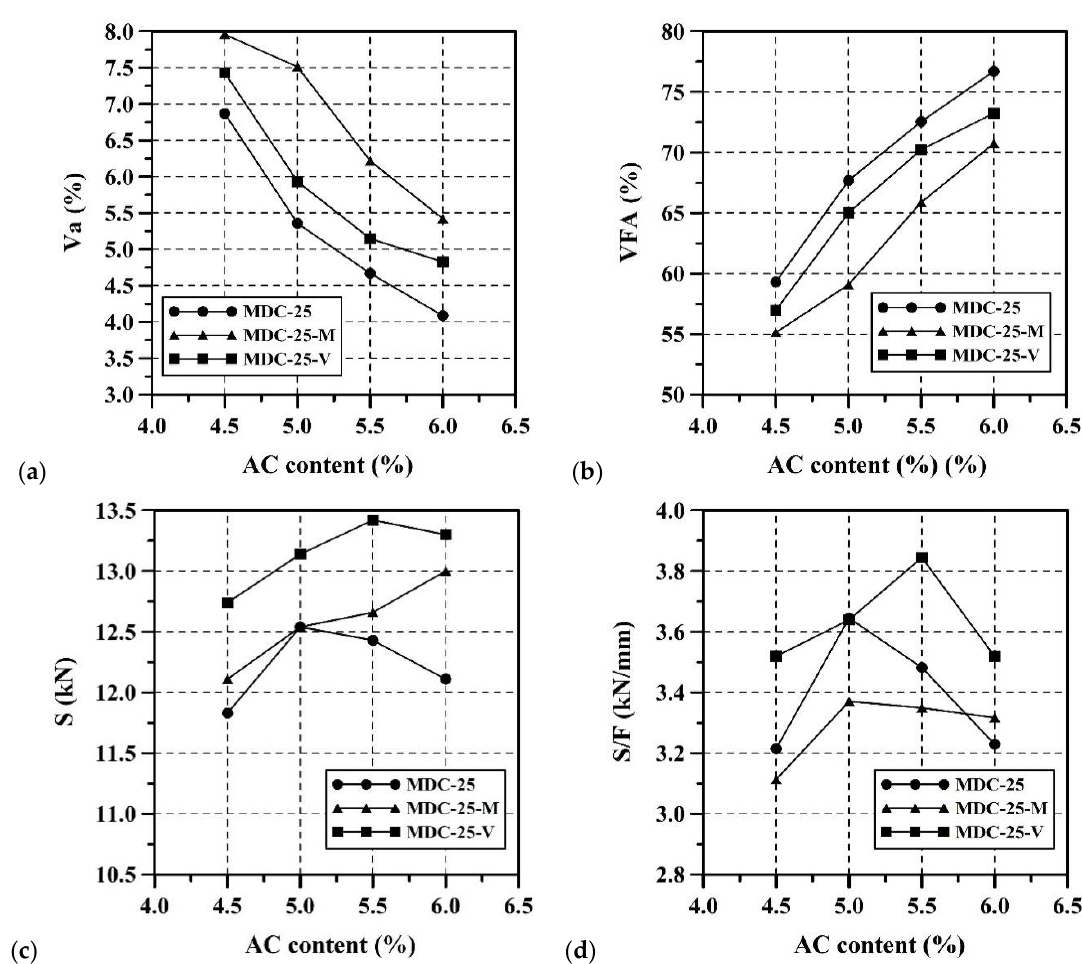
Figure 4. Marshall test results of MDC-25, MDC-25-M, and MDC-25-V: ( a ) Va content; ( b ) VFA content; ( c ) stability—S; ( d ) S/F ratio. Table 4. Values of Marshall test results in OAC.